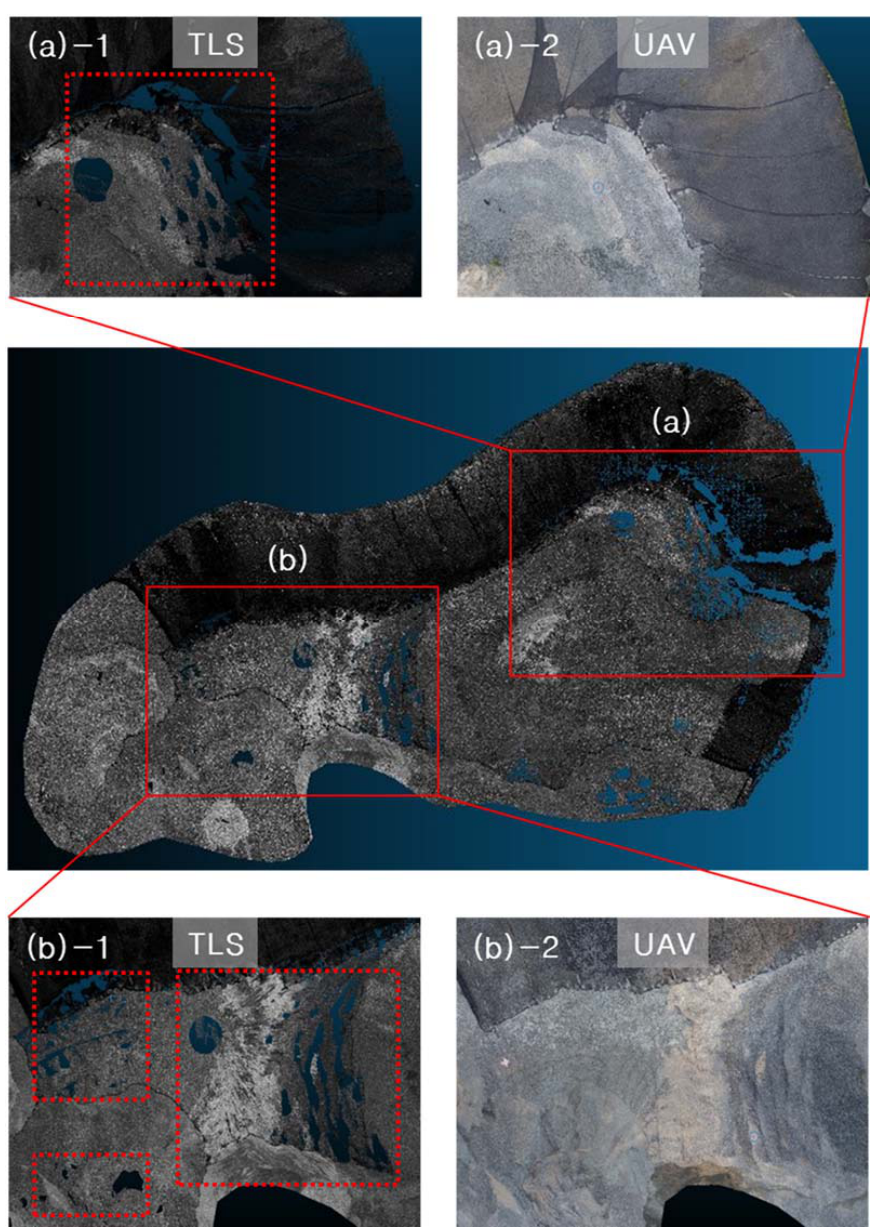
Figure 6. Top views of the waste point clouds: ( a ) ‐ 1 TLS ‐ based point cloud and ( a ) ‐ 2 UAV ‐ based cloud; ( b )-1 TLS-based point cloud and ( b )-2 UAV-based point